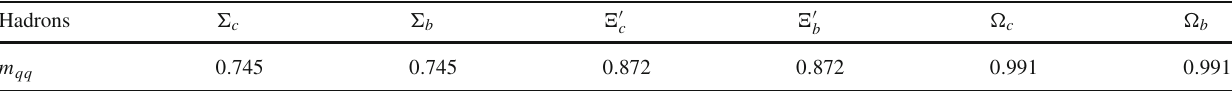
Table 5 Effective masses (in GeV) of light diquarks in the singly heavy baryons shown. Data are from the Refs. [29,31] Hadrons